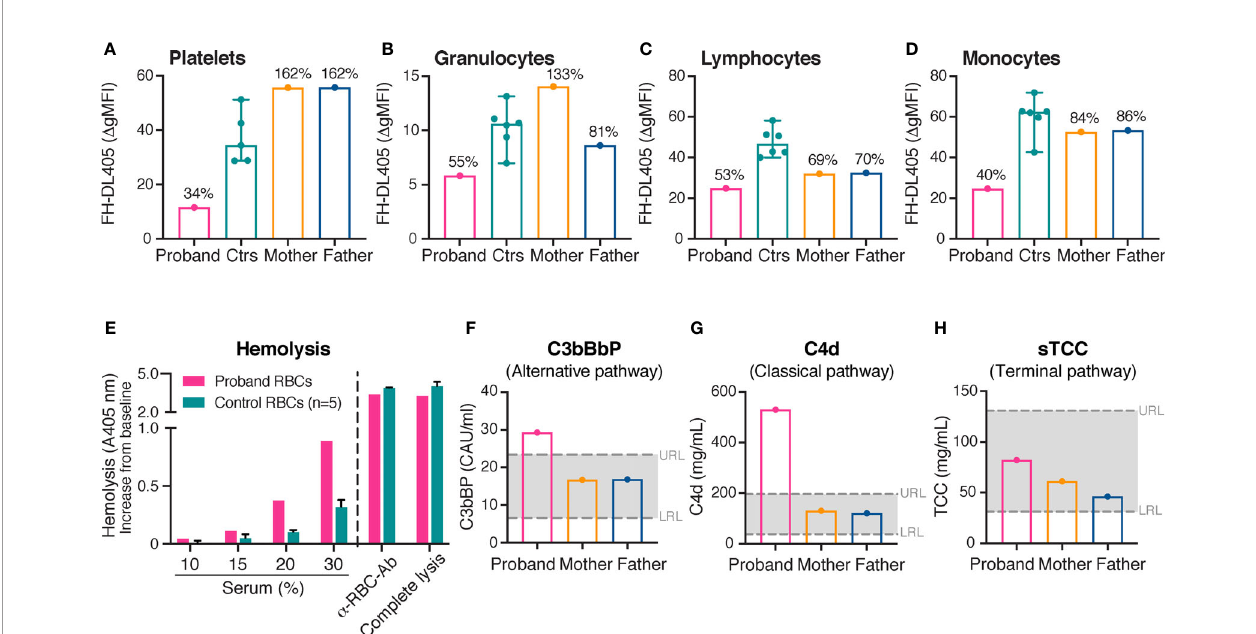
FIGURE 2 | Binding of complement inhibitor FH on platelets and leukocytes, hemolytic assay and complement activation. (A – H) FH binding to platelets (A) , granulocytes (B) , lymphocytes (C) and monocytes (D) . Binding of FH was investigated by fl ow cytometry using puri fi ed DyLight 405-labeled FH (175 m g/mL). A decreased binding of FH to all cell types was demonstrated in the proband compared with healthy controls. The heterozygous parents showed normal binding of FH to platelets, granulocytes and monocytes; FH binding to lymphocytes was however slightly reduced compared with healthy controls. The results of the healthy controls (platelets, n = 5; granulocytes, lymphocytes and monocytes, n = 6) are shown as medians with min-max. The results in the proband and the parents are presented as percentages of the median D gMFI in the control group. (E) Assessment of hemolysis. Washed erythrocytes from the proband and healthy controls were incubated with normal human serum in increasing concentrations from 10% to 30%. An anti-erythrocyte antibody was added to 10% serum to con fi rm the possibility of complement mediated hemolysis. For comparison, complete lysis (erythrocytes treated with H 2 O) is shown. Free hemoglobin was measured by absorbance at 405 nm. The increase in absorbance from baseline (0% serum) is shown on the Y-axis. An increased rate of hemolysis was observed in the proband compared with healthy controls. The results of the healthy controls ( n = 5) are shown as medians with max. (F – H) Levels of alternative (C3bBbP), classical/lectin (C4d) and terminal complement pathway (sTCC) activation. A moderate activation of the alternative and the classical/lectin complement pathways was observed in the proband, but not in his parents. gMFI, geometric mean fl uorescence intensity; FH, complement inhibitor factor H; RBC, erythrocyte; Ab, antibody; A, absorbance; URL, upper reference limit; LRL, lower reference